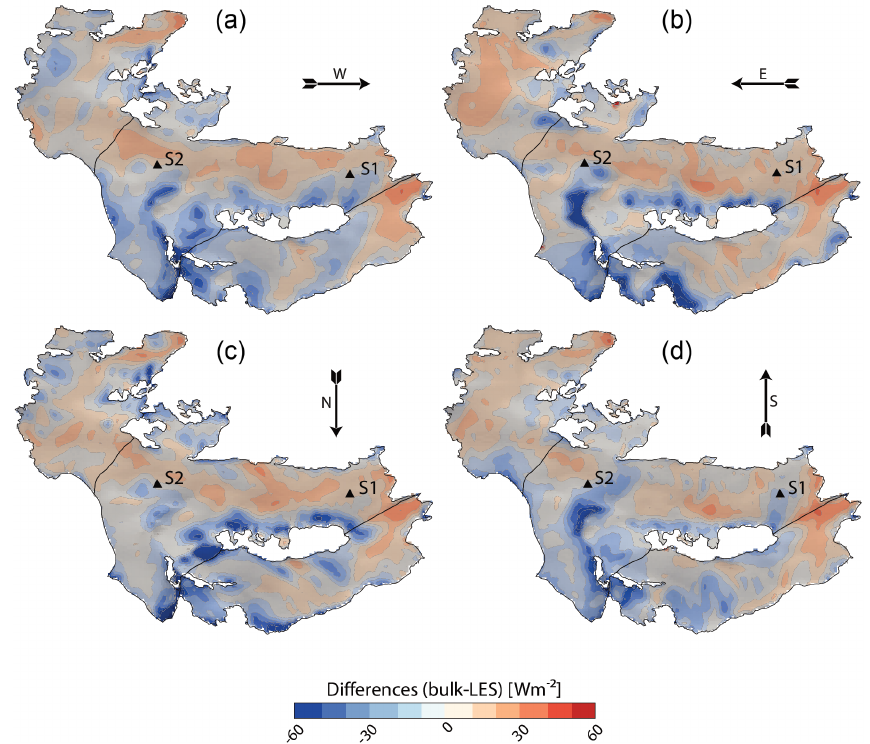
Figure 10. Differences in the mean surface sensible heat fluxes between the LES and the bulk method for different wind direction. Positive differences correspond to an overestimation of the surface heat flux by the bulk